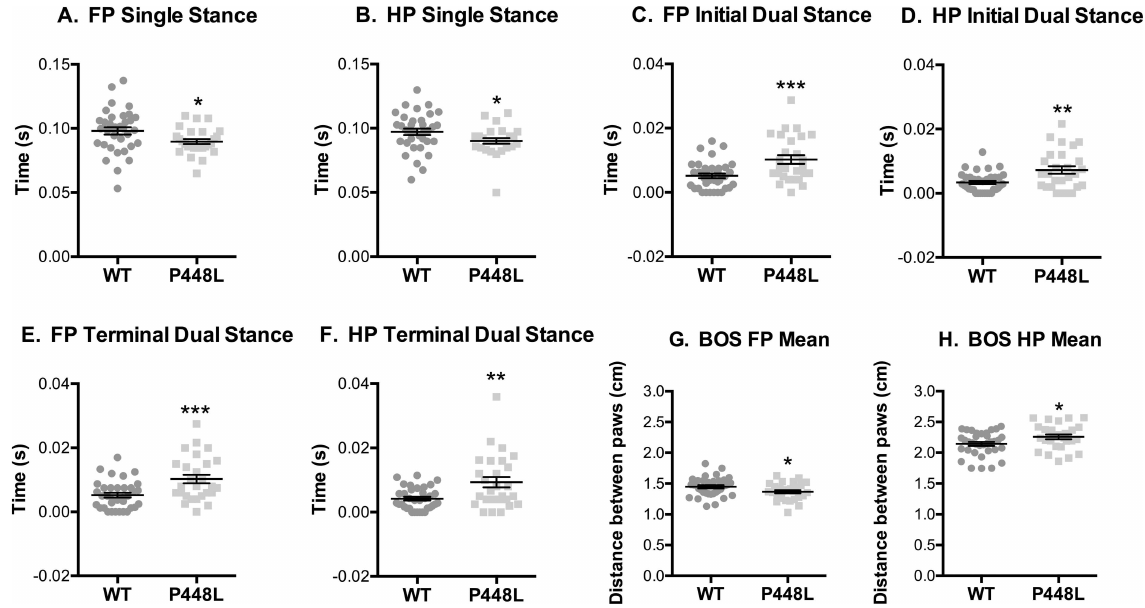
Fig 6. Stanceand ContralateralPaws. (A,B)Fore paw and hindpaw measurement of ground contact durationfor a single paw while the contralateral paw is airborne.(C,D) The timecontralateral paws simultaneously contactthe ground at the beginningof a step and (E,F)at the end of a step. (G,H)The distancebetween contralateral paws while both are in stance phase. (FP = fore paw, HP = hindpaw, n = 12; * p < 0.05; ** p (cid:20) 0.01, *** p (cid:20) 0.001).